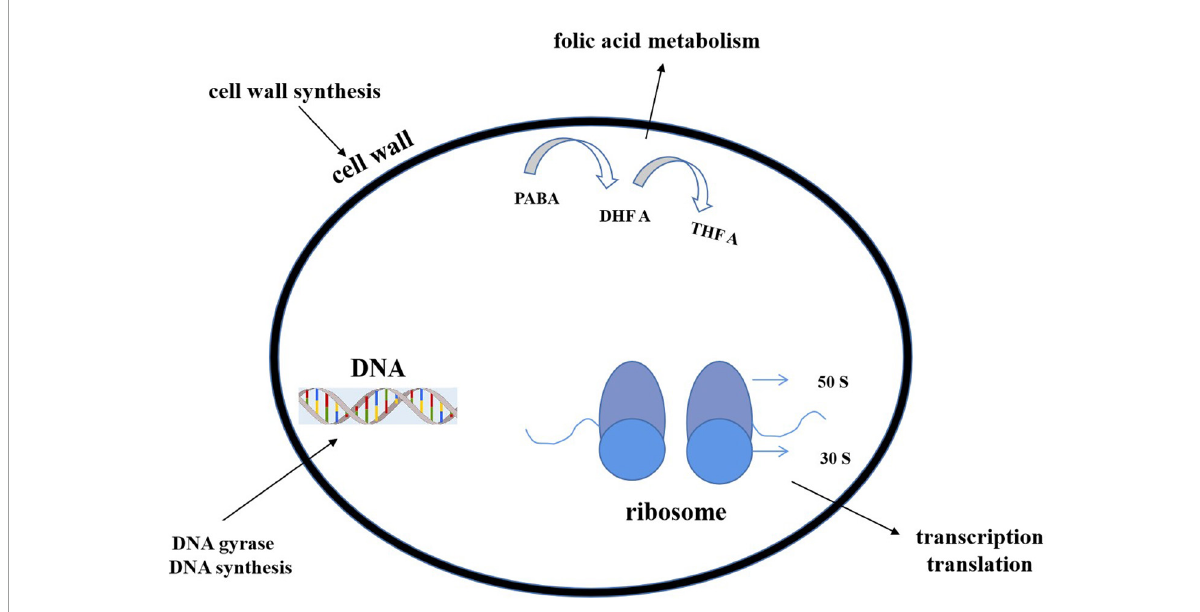
FIGURE10 Action modes of antibacterial compounds. By targeting the bacterial cell wall/cell membrane, antibiotics inhibit bacterial growth. The synthesis of nucleic acids and proteins are two further targets. The latter is a function of ribosomes, which are nucleoprotein complexes made up of a small and large subunit (30 S and 50 S in bacteria, as shown in the figure). Antibiotics can also operate as antimetabolites by blocking folate metabolism (and thus DNA synthesis) through a pathway that includes para aminobenzoic acid (PABA) and two folic acid precursors, dihydrofolic acid (DHF) and tetrahydrofolic acid (THFA) (THF). Antibiotics can stop DNA gyrase from changing the shape of DNA, which is important for replication and